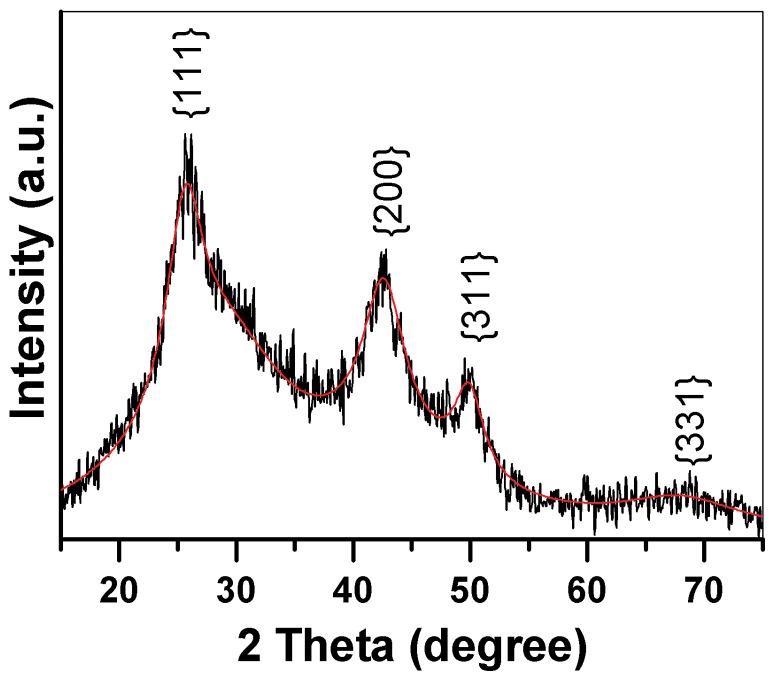
XRD pattern of as-prepared CdSe0.2S0.8 nanocrystals.